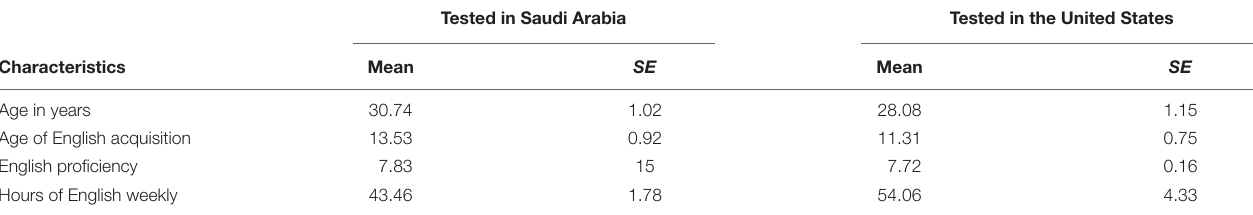
TABLE 1 | Descriptive statistics for demographic variables for Arabic–Bilinguals in Experiment 1 by testing